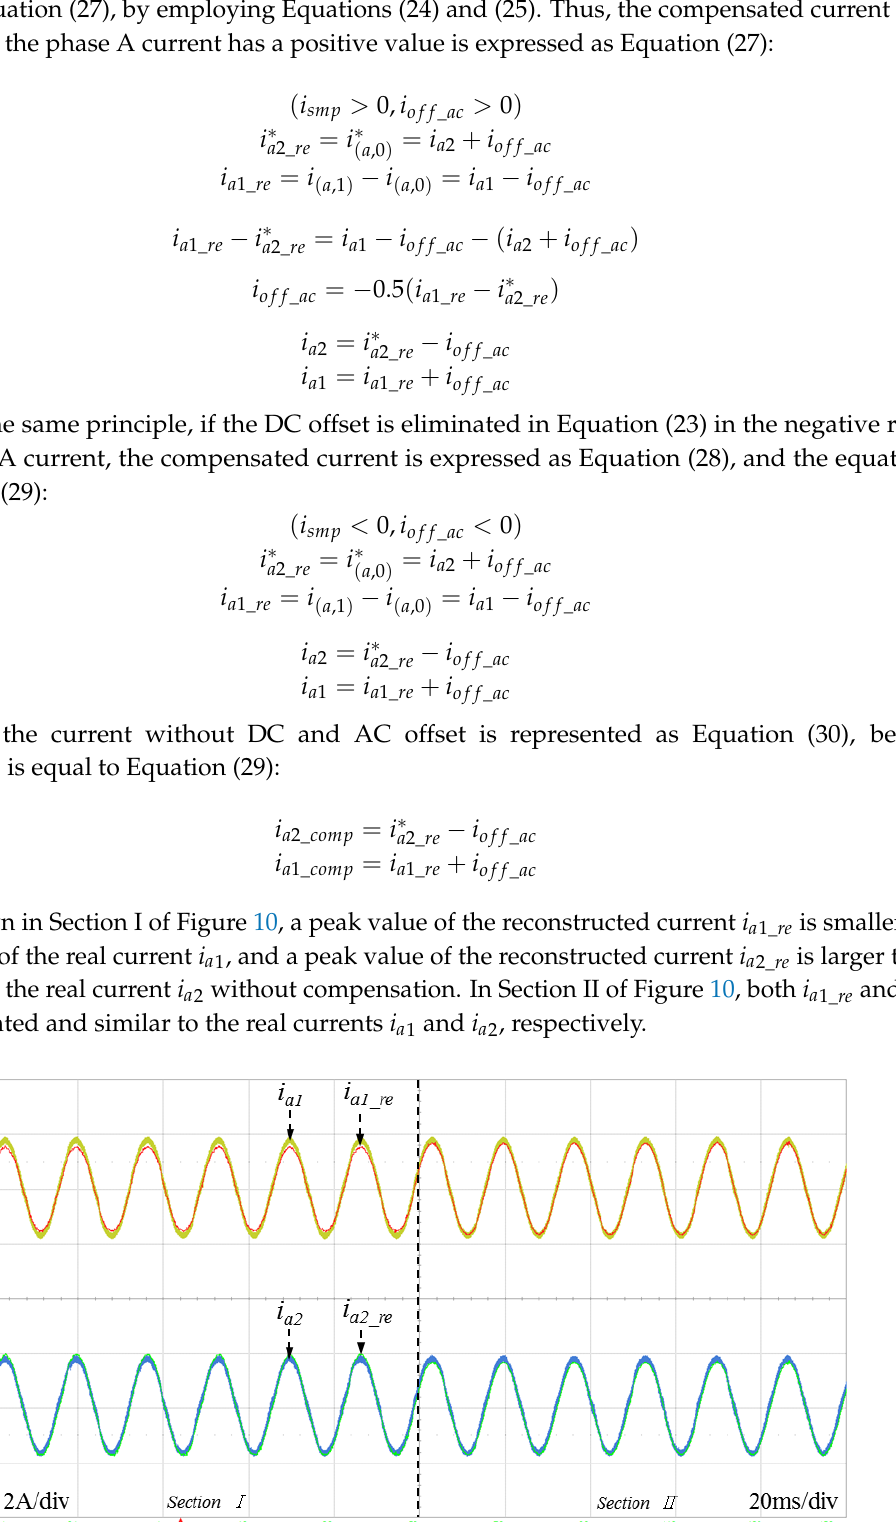
Figure 10. The actual current and reconstructed currents with and without the proposed offset compensation algorithm being applied.